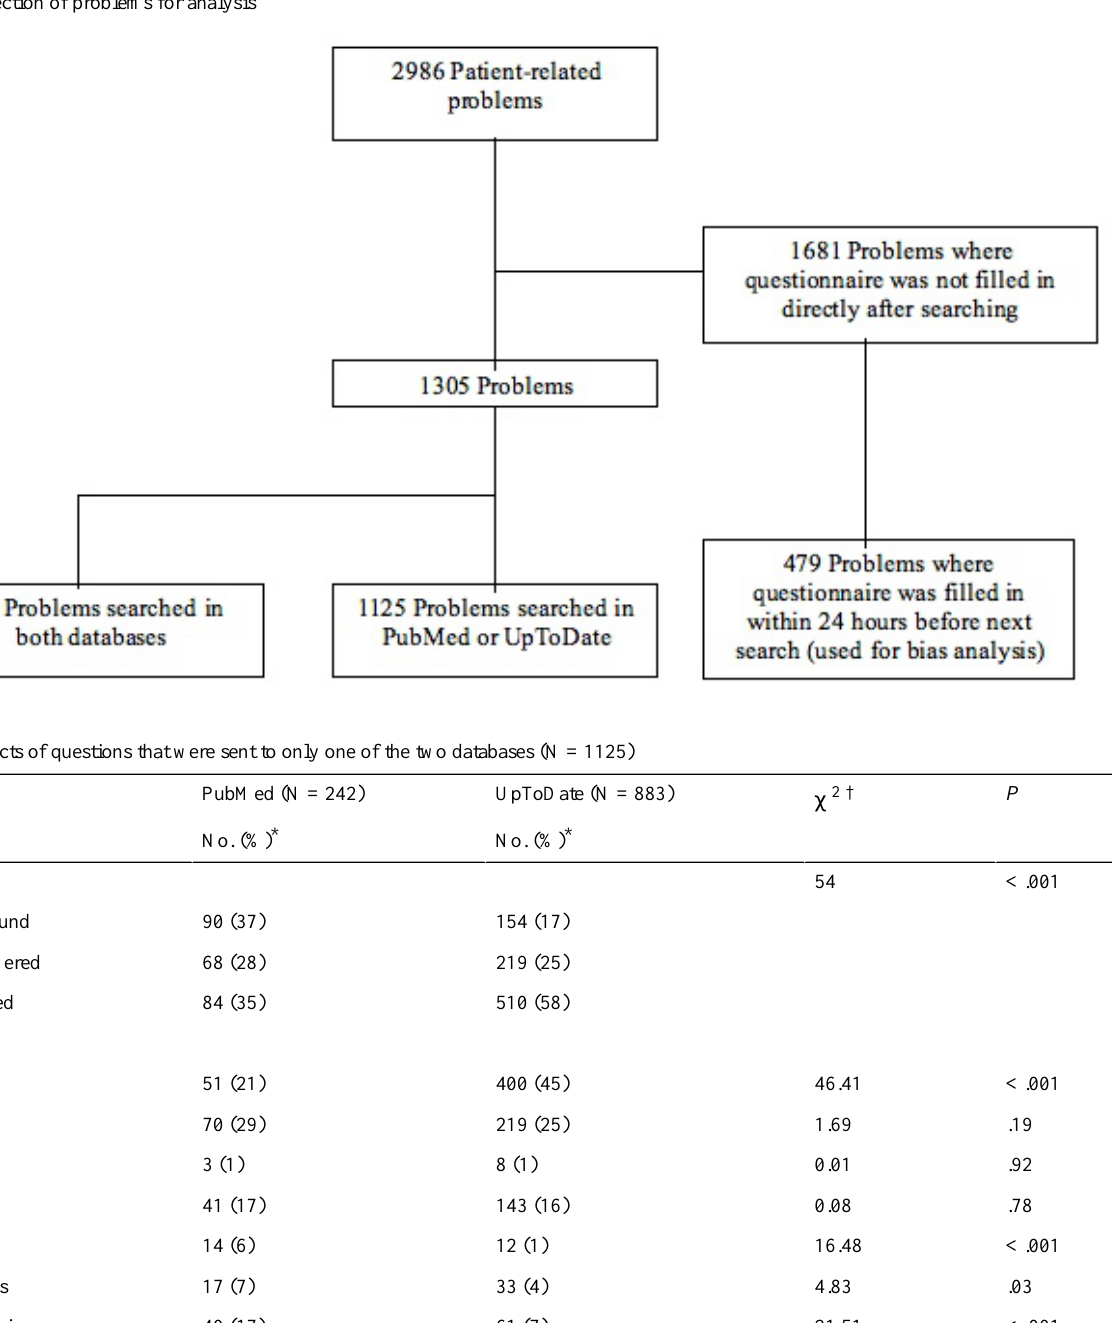
Figure 6. Selection of problems for analysis